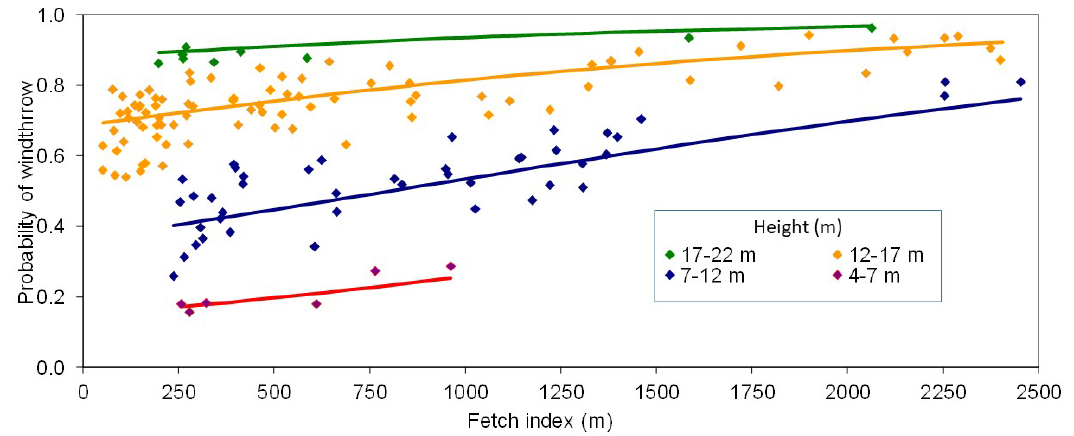
Figure 2. Probability of the occurrence of windthrow in clearcut edges, in relation with the fetch index and stand height [30].